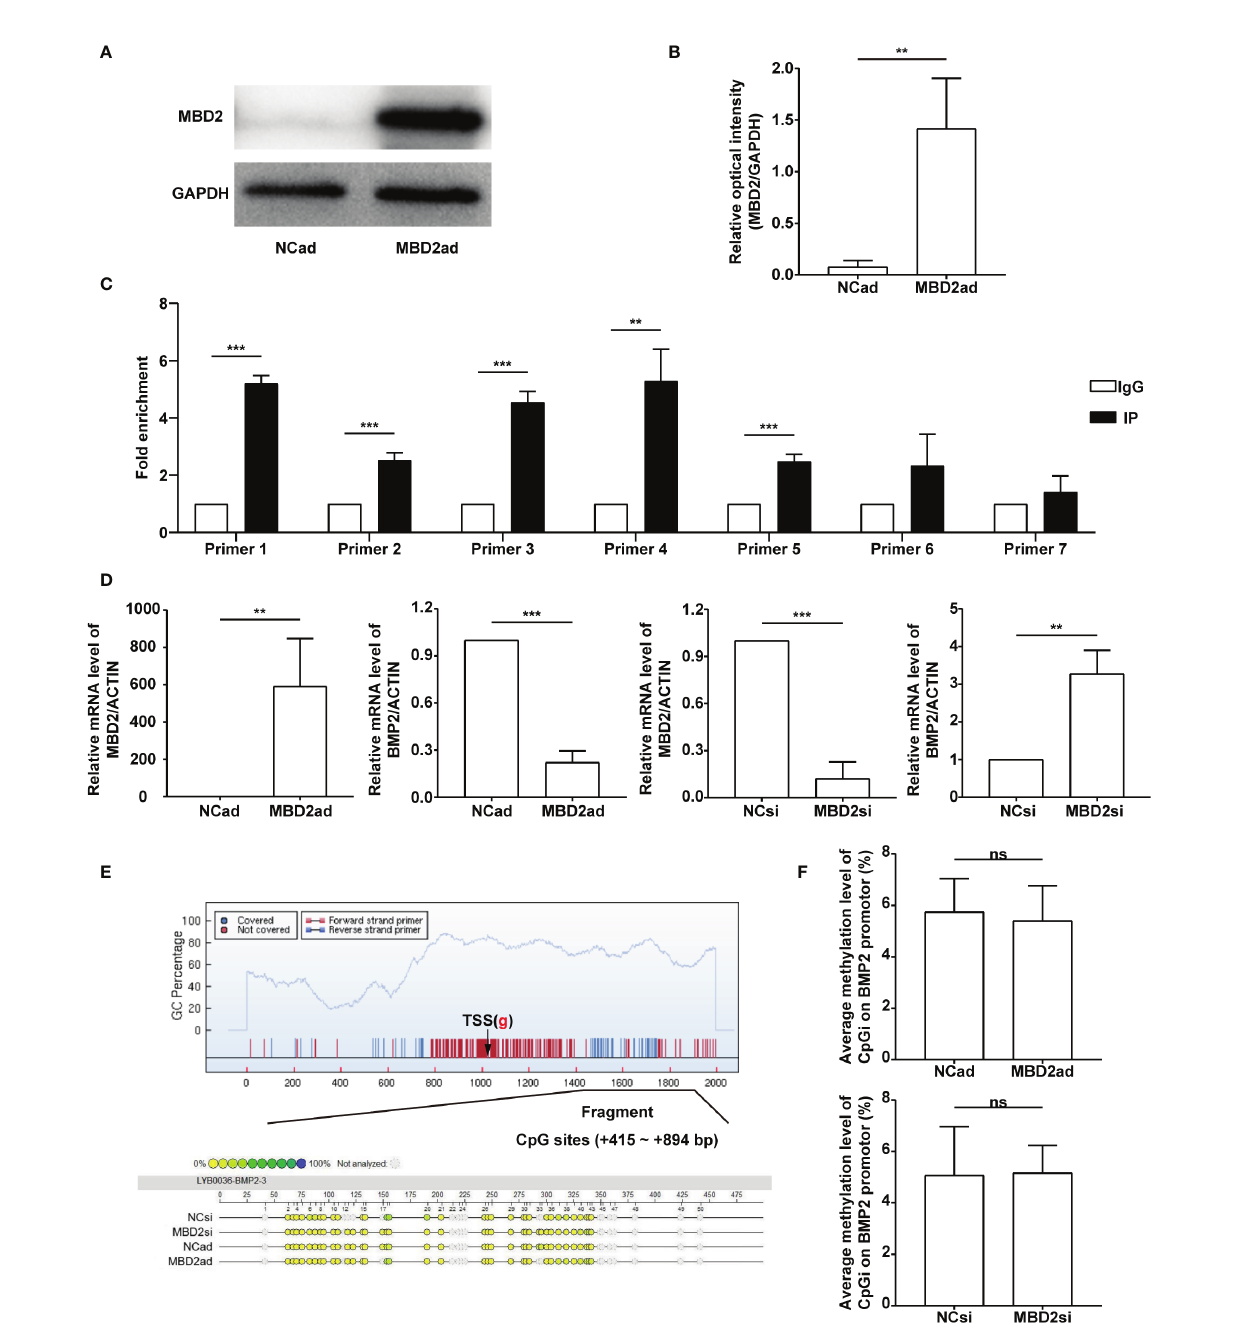
FIGURE 6 | MBD2 can directly bind to the BMP2 gene ’ s promoter. (A) MBD2 overexpression adenovirus vector (MBD2ad) increases MBD2 protein expression in HPASMCs. (B) Quantitative analysis results of graph A based on the density of the bands. (n=3) (C) The ChIP-qPCR results indicate that MBD2 can directly bind to the BMP2 gene ’ s promoter. (n=3) (D) RT-qPCR results indicate that MBD2 can in fl uence BMP2 expression at the transcriptional level. The samples were collected for the MassARRAY. (MBD2ad group, n=6; MBD2si group, n=5) (E) Representative images of the MassARRAY assay. (F) Average methylation level of CpG islands on BMP2 promoter (MBD2ad group, n=6; MBD2si group, n=5). The data are presented as mean ± SD. ** P < 0.01, *** P < 0.001, ns, no signi fi